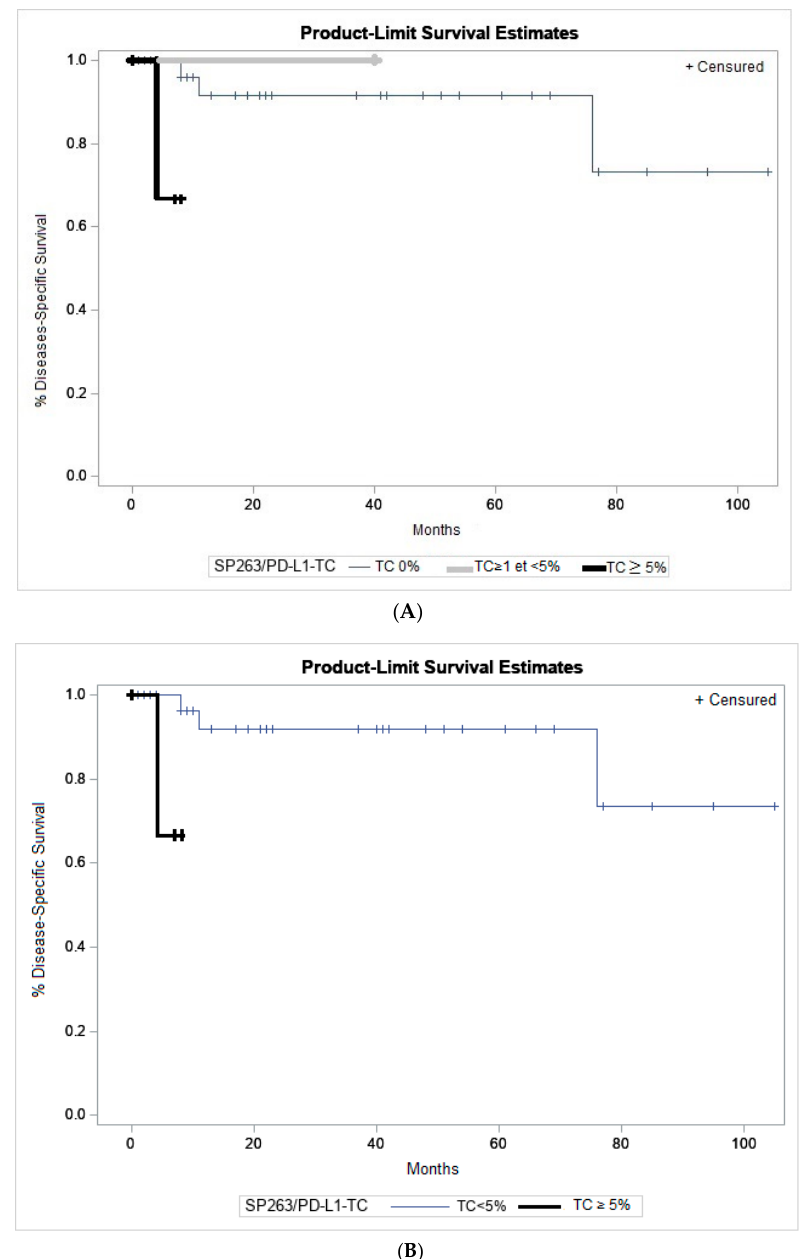
Figure 3. Kaplan–Meier analysis of disease-specific survival (melanoma-related death) according to the PD-L1 expression. SP263/PD-L1/TC+ was significantly associated with worse disease-specific survival in CM. ( A ) TC0 versus TC ≥ 1% and <5% versus TC ≥ 5% ( p = 0.046). ( B ) TC0 and TC < 5% versus TC ≥ 5% ( p = 0.013).